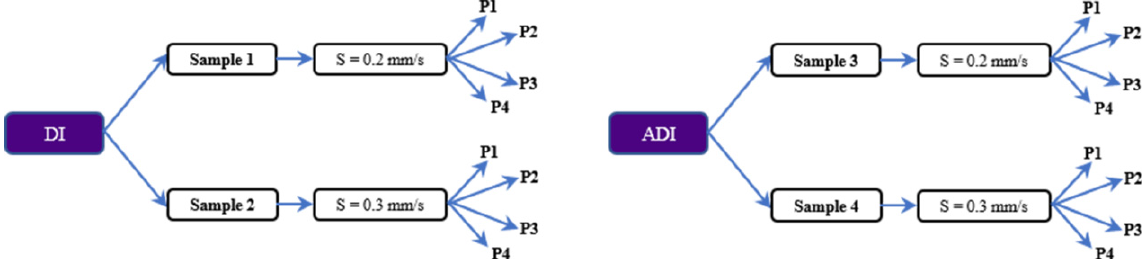
Figure 2. Design of experiments for the laser surface hardening.